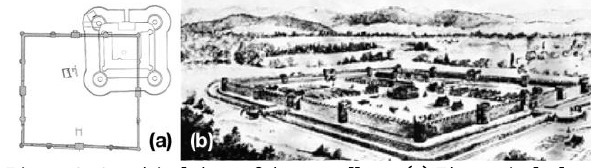
Figure 6. Graphical data of the castellum; (a) Theoretical